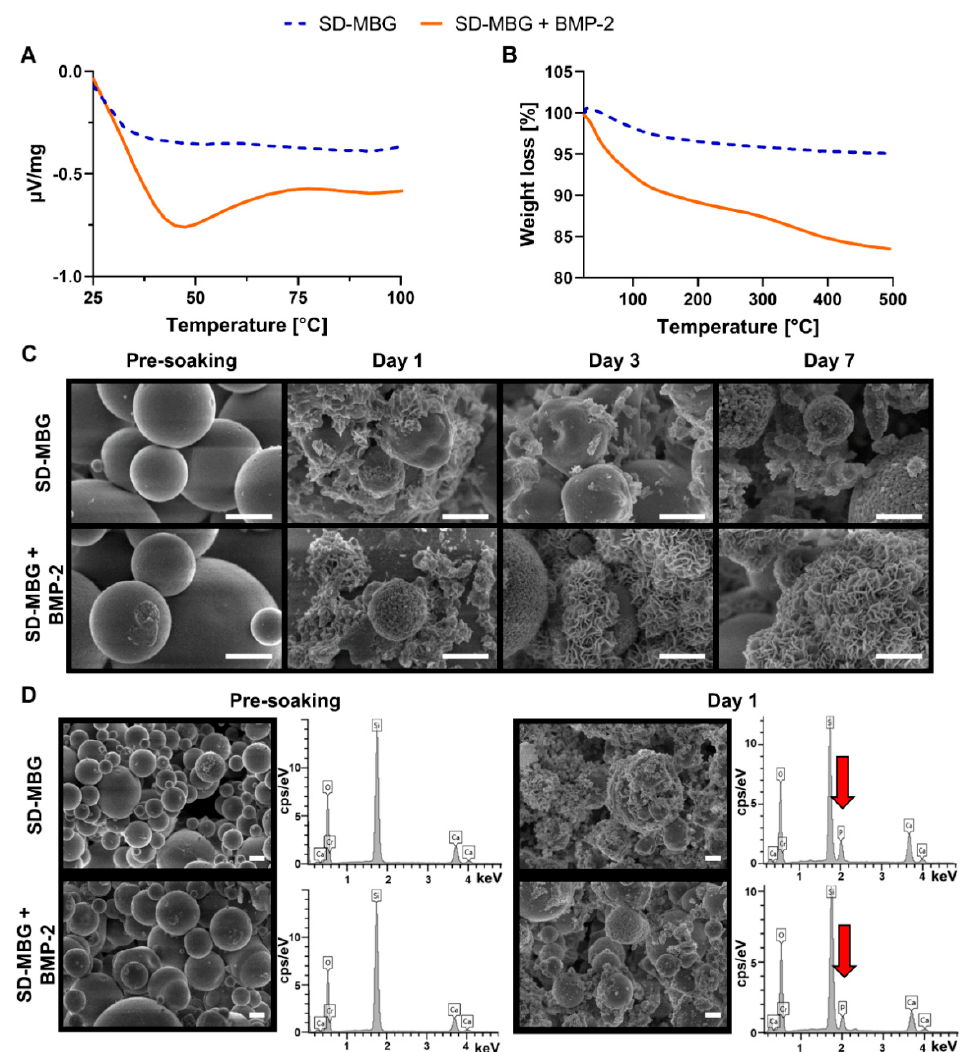
Figure 1. Thermoanalytical and morphological characterization of spray dried mesoporous bioactive glass (SD-MBG) and SD-MBG + bone morphogenetic protein-2 (BMP-2). ( A ) Differential thermal analysis (DTA) and ( B ) thermogravimetric analysis (TGA) showing an endothermic peak and pronounced weight loss only for SD-MBG + BMP-2, respectively, thereby confirming the loading of the protein. ( C ) Field-emission scanning electron microscopy (FE-SEM) of SD-MBG (top) and SD-MBG + BMP-2 (bottom) pre-soaking and at one, three and five days of soaking in simulated body fluid (SBF). Starting at day one of soaking, hydroxyapatite formation can be detected by increasing roughness of the material surface and ( D ) energy-dispersive X-ray spectroscopy (EDS) analysis. Only after soaking in SBF, the EDS spectra yield a peak for phosphate (red arrows). Scale bar = 1 µm.